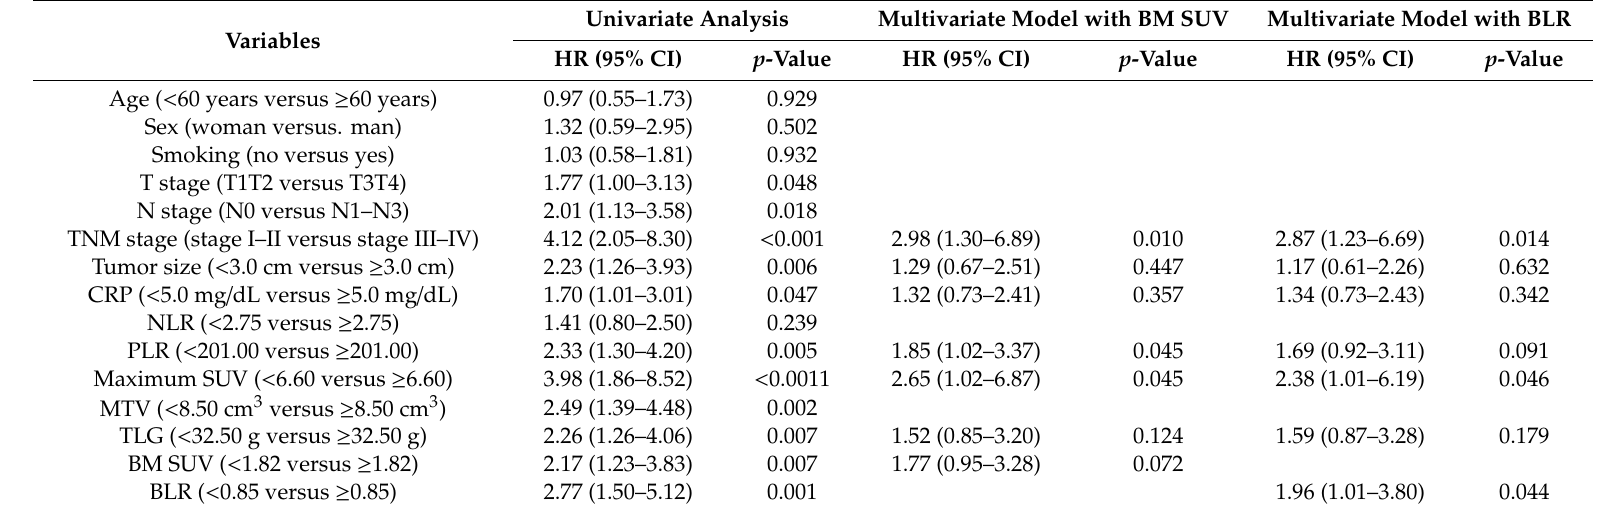
Table 3. Univariate and multivariate analyses of disease progression-free